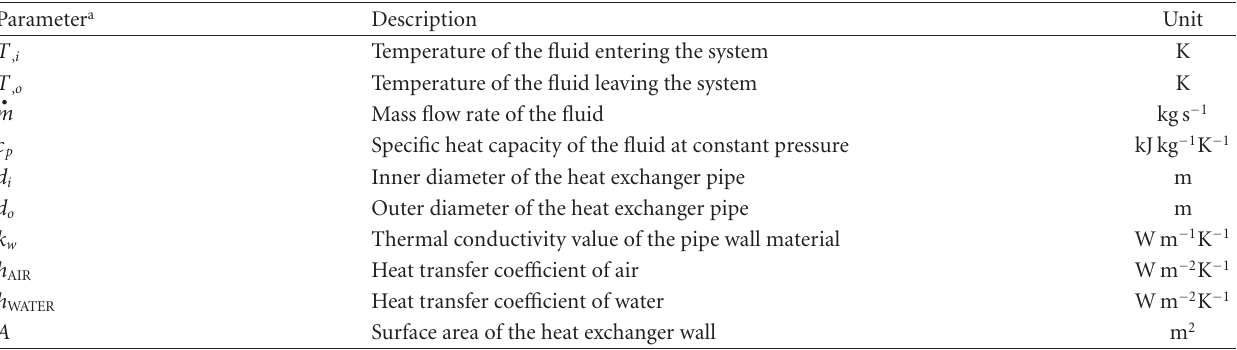
Table 2: Nomenclature.